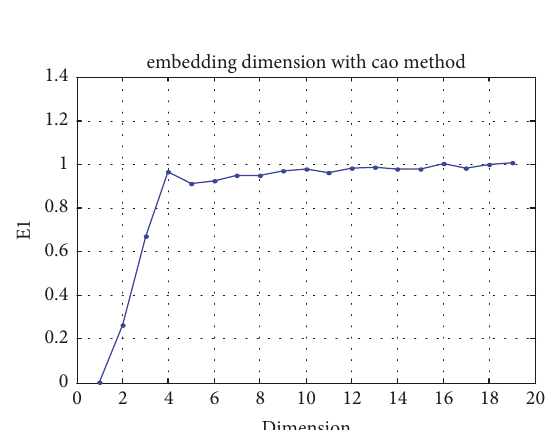
Figure 5: Selection of the embedding